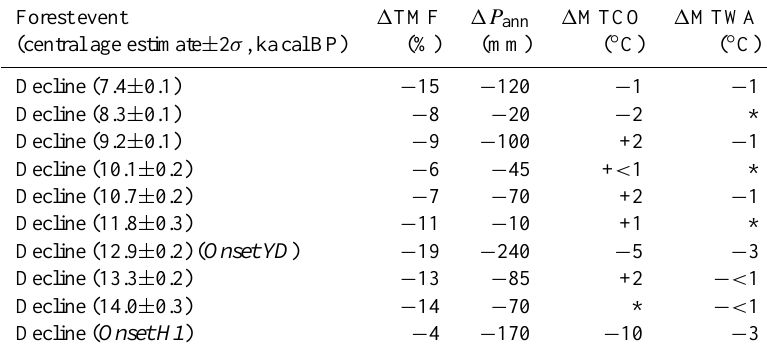
Table 2. Anomalies in temperate Mediterranean forest (TMF) values and MAT reconstructions associated with MD95-2043 forest decline events, calculated on the basis of changes in the smoothed (3-point moving average) values relative to the preceding